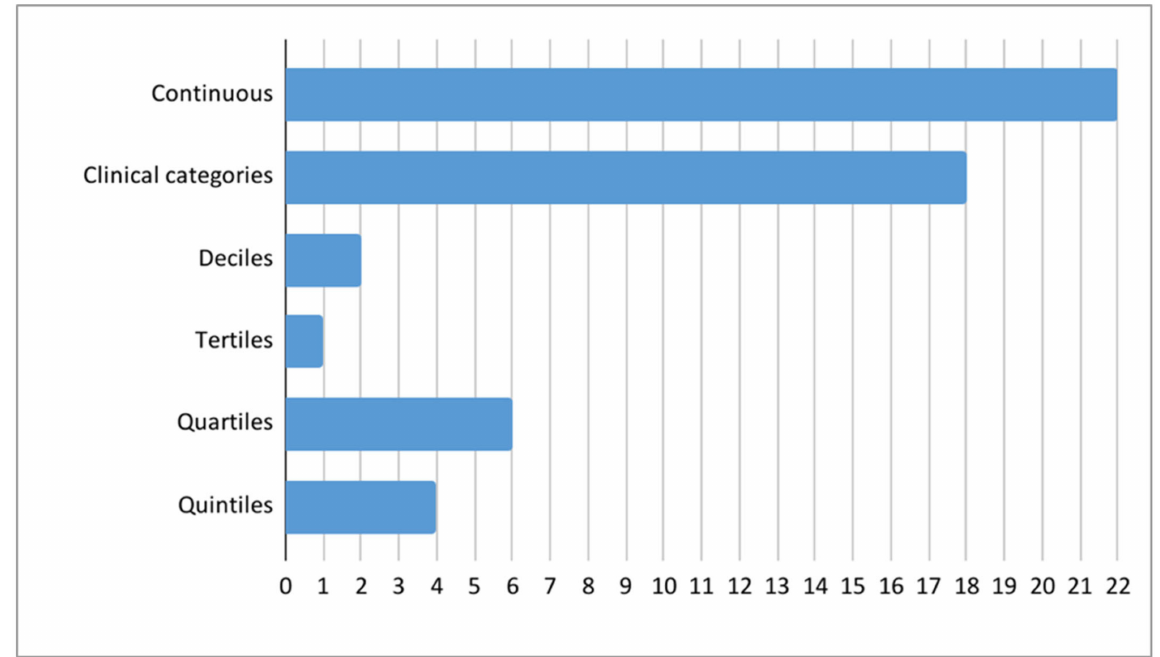
Figure 4. The number of studies by the methods of examining vitamin D levels. Many studies had more than one way to examine vitamin D